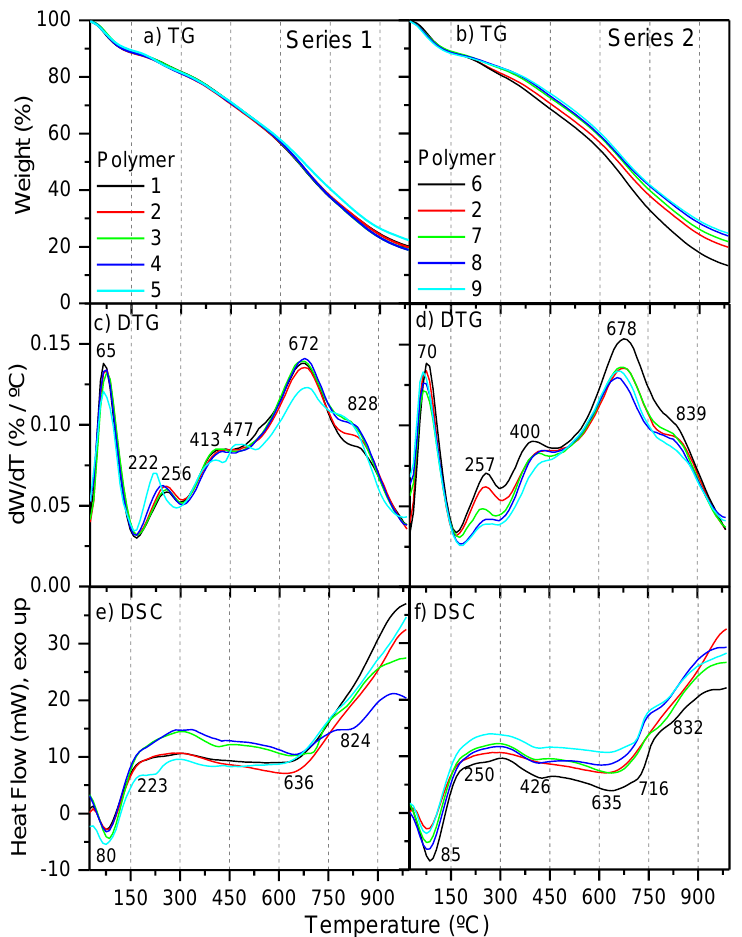
Figure 4. Thermal analyses for representative samples of polymers 1 – 9 . ( a , b ) TG curves; ( c , d ) DTG curves; ( e , f ) DSC curves.